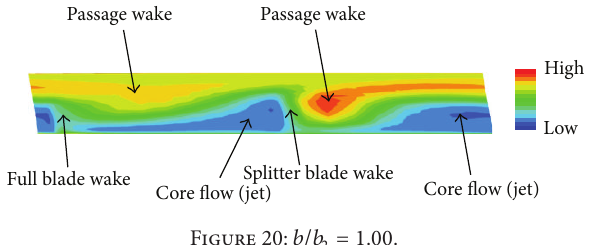
Figure 20: 𝑏/𝑏 2 = 1.00 .